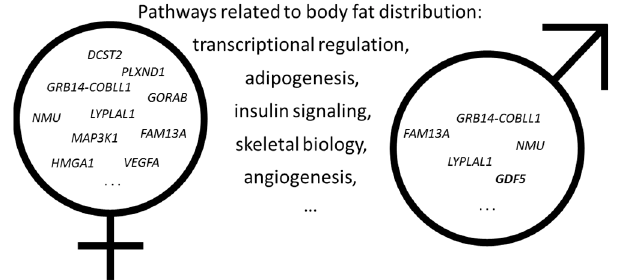
Figure 1. Sexual dimorphism in genetically determined body fat distribution and related pathways.